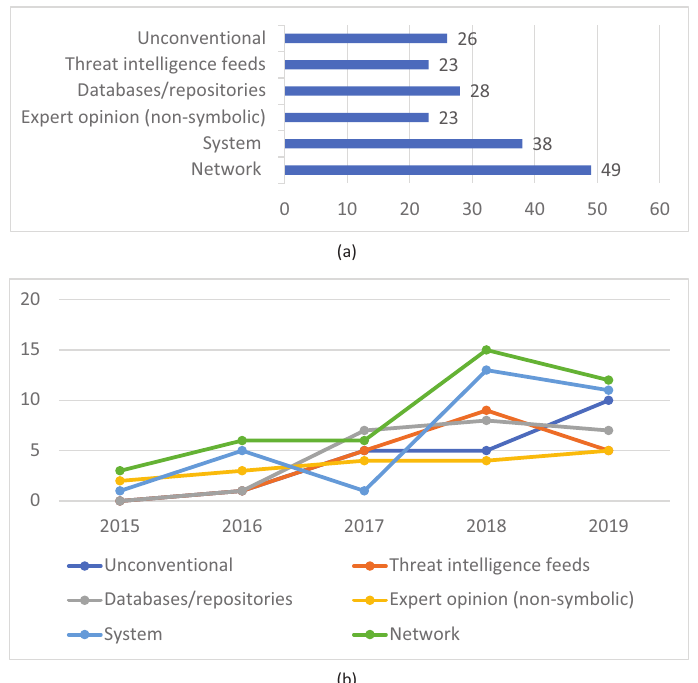
Figure 7. ( a ) Data source categories addressed by 20 or more primary studies; and ( b ) number of primary studies addressing data source categories in the